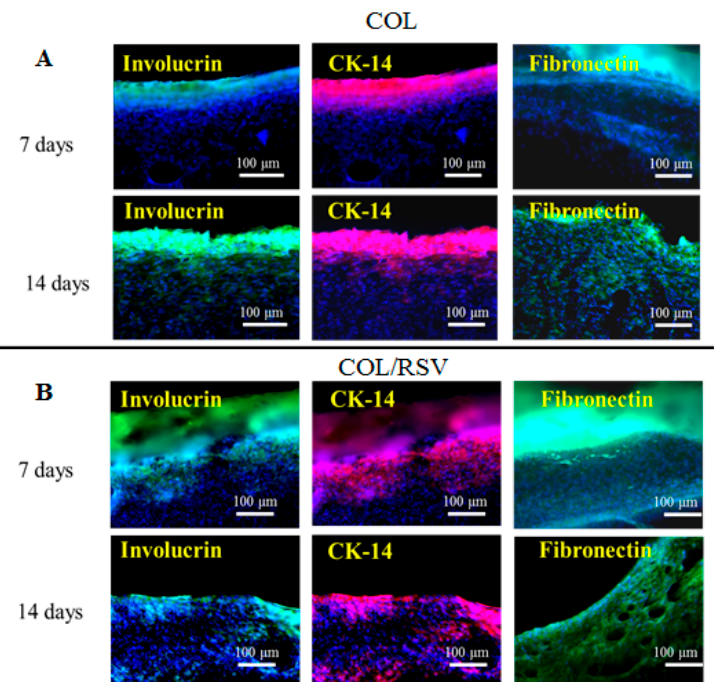
Figure 11. Keratinocyte differentiation on COL- and COL/RSV-scaffold implants in skin defects after 7 and 14 d. The COL/RSV group showed relatively higher levels of involucrin- (green) and CK-14- (red) positive keratinocytes. Nuclei were counterstained with Hoechst 33342 (blue). Scale bar = 100 µ m. The COL and the COL / RSV sca ff olds displayed fibronectin (green) expression, indicating ECM formation and re-epithelialization during wound